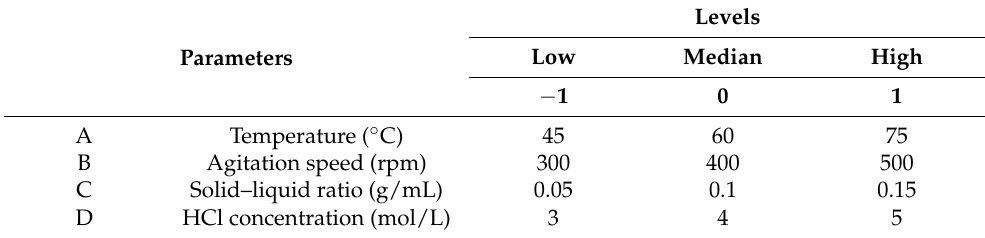
Table 2. Parameters and corresponding levels tested in the leaching studies.